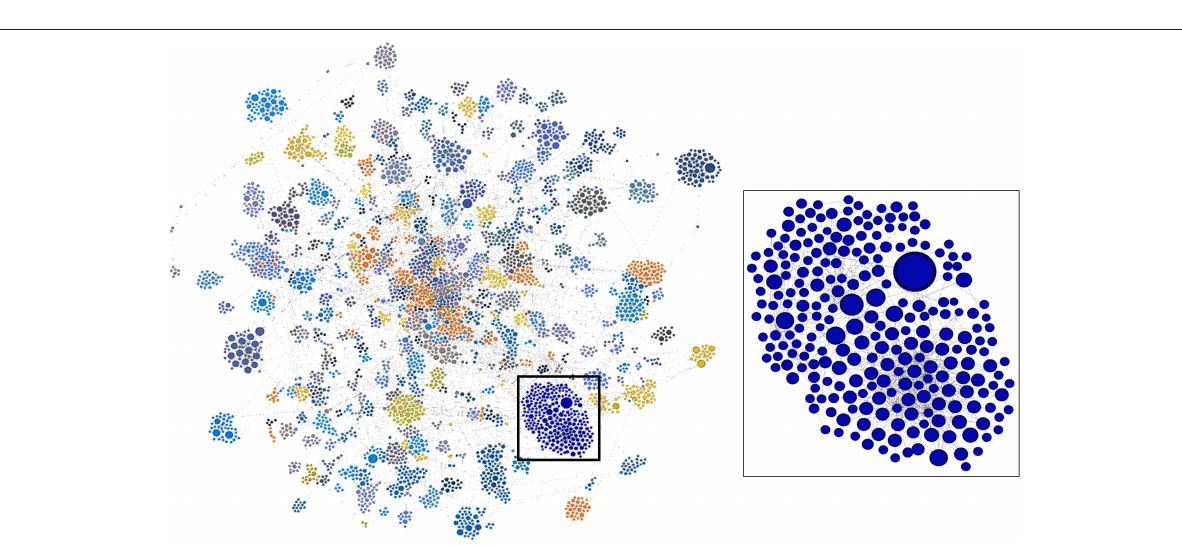
Frontiers in Research Metrics and Analytics |